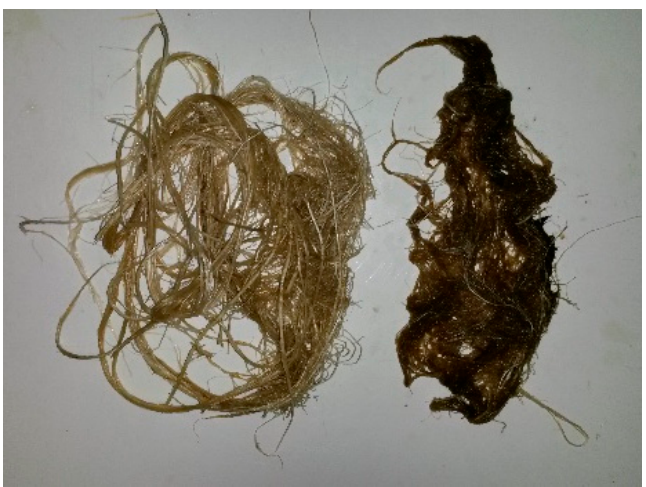
Figure A4. Difference between healthy roots in the middle and rotten roots in the corners of the raft culture basin.